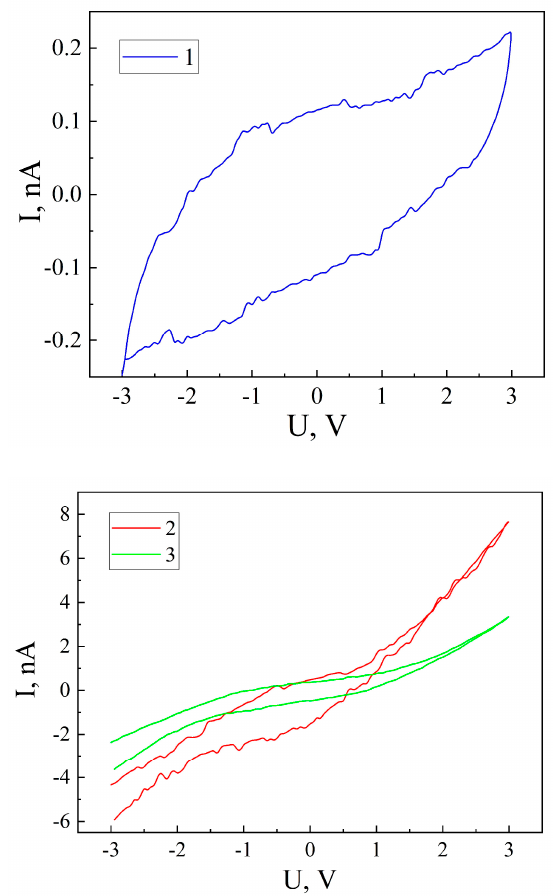
Figure 8. I-V curves of encapsulate MSM-41<SFA>, measured under normal conditions (1), in a magnetic field (2), and under illumination (3).